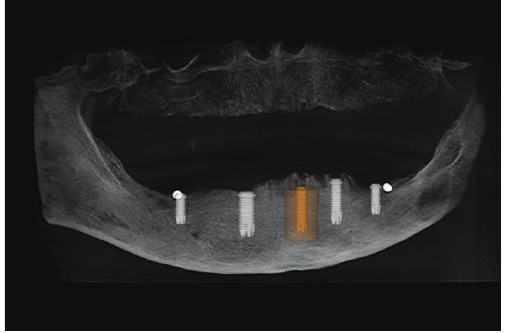
Figure 3: Computer-guided implants technique.